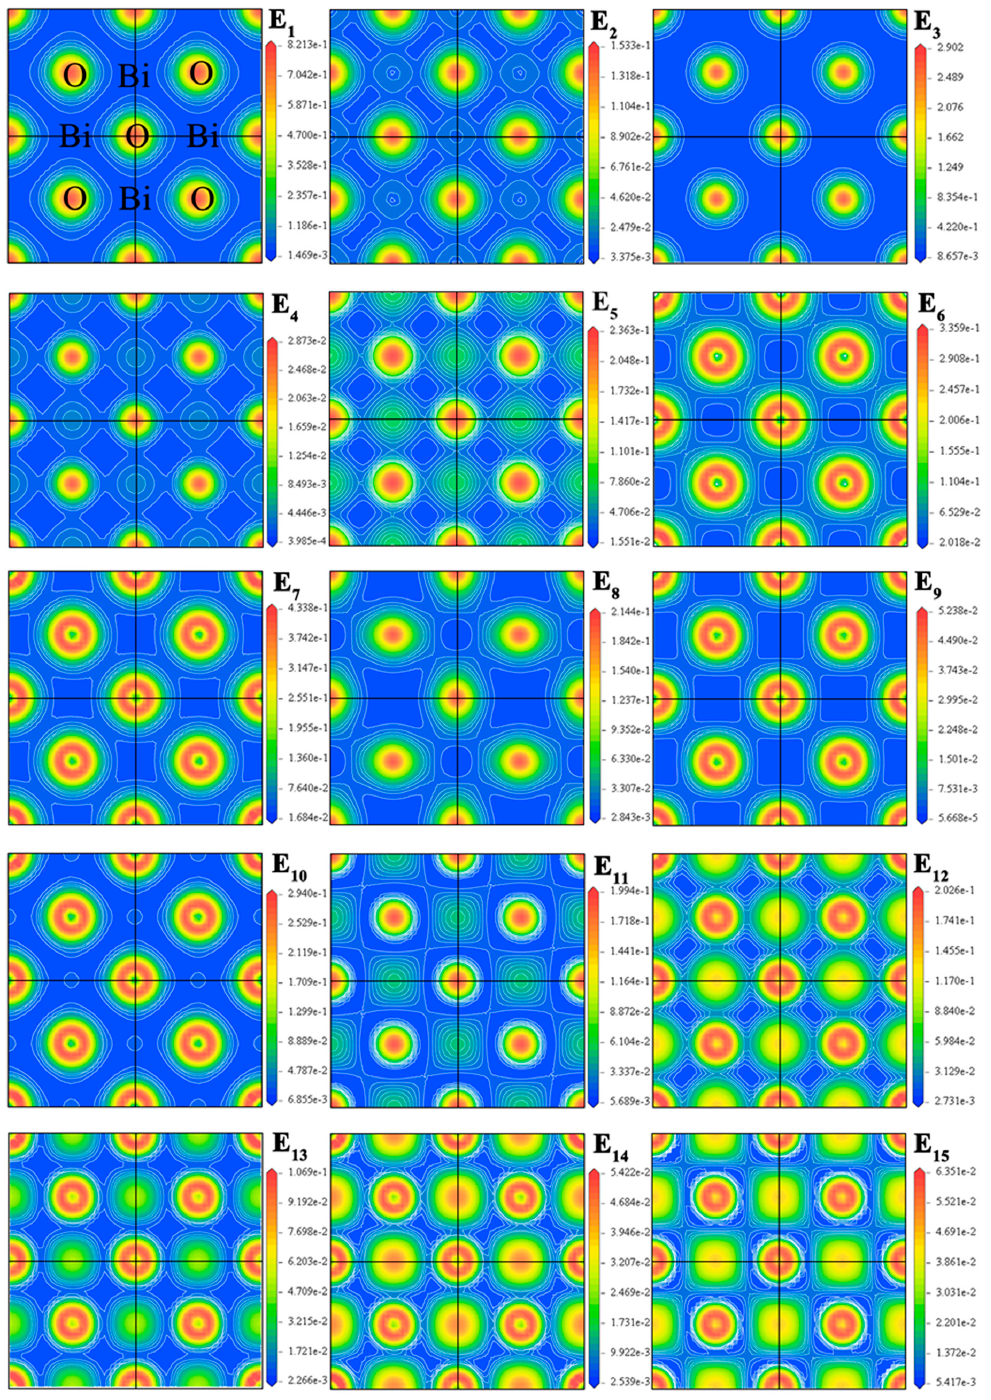
Figure 5. Projected wave function contour of BiOI through the (001) plane. The energy regions E 1 –E 15 are as labeled in Figure 2.